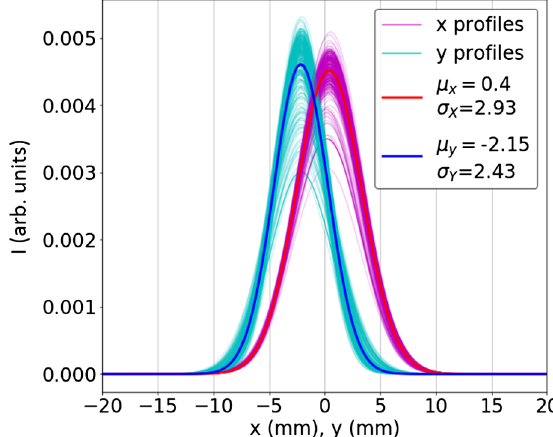
FIG. 14. Beam profile along the horizontal (x) and vertical (y) directions recorded by the upstream BTV during the beam tests at medium intensity ( 3 . 25 × 10 12 ppp). A total of 750 beam pulses are presented, as well as the average beam profile in both directions. The beam centroid has an offset of about 2 mm down in the vertical direction. The beam spot size on target is around 2 . 9 × 2 . 4 mm 1 σ , fairly comparable to the requested beam size ( 3 × 2 . 5 mm 1 σ on target in the horizontal and vertical plane, extracted from the upstream BTV data recorded during the tests at medium intensity ( 3 . 25 × 10 12 ppp), coupled to a Gaussian fit.